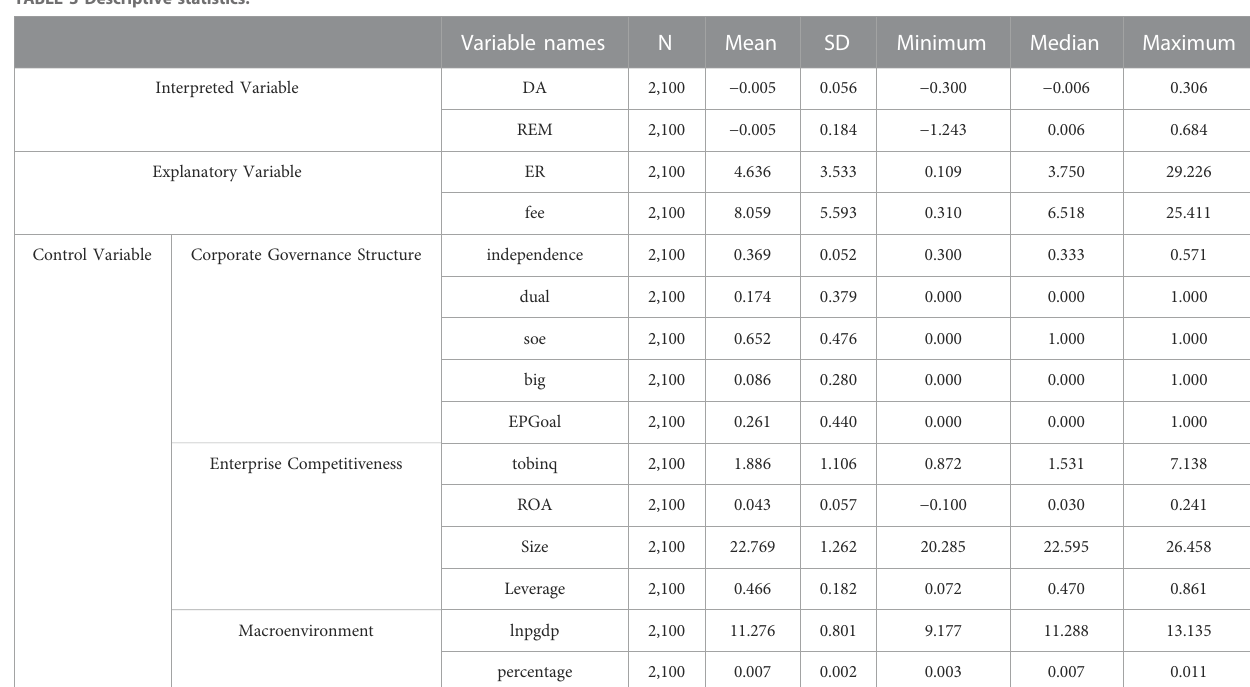
TABLE 3 Descriptive